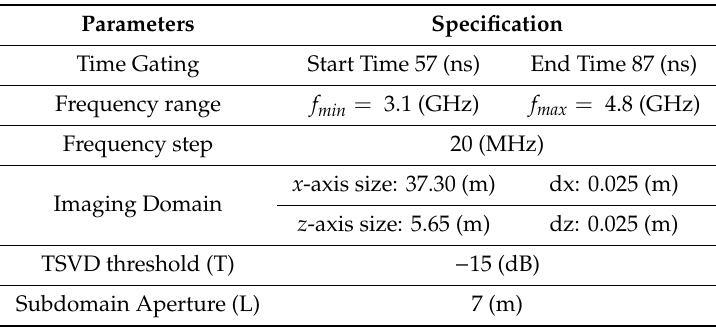
Table 2. Signal Processing Parameters: Track 1. Table 3. Signal Processing Parameters: Track